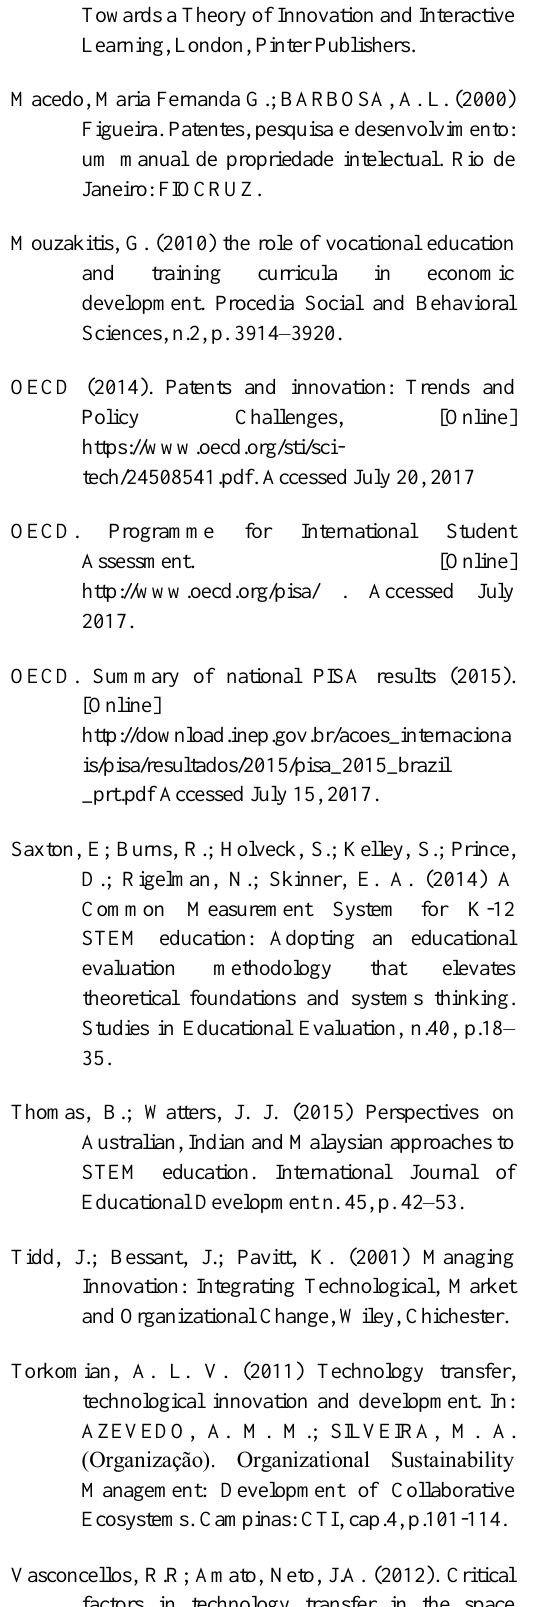
(„AEB‟) and the USA